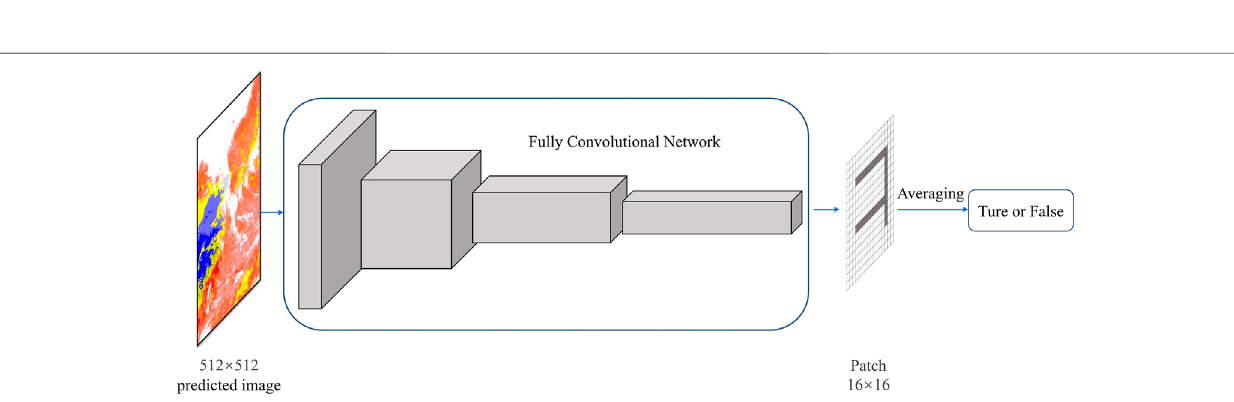
FIGURE 4 | Architecture of